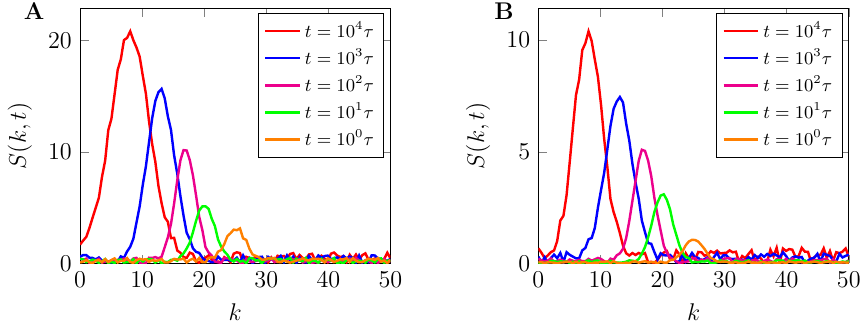
Figure 7. Spherically averaged structure functions. ( A ) Structure function corresponding to Fig- ures 5A and ( B ) structure function corresponding to Figure 6A at different times plotted against k the wavenumber k = . As can be observed, both structure functions reveal several controllable | | characteristic length scales that emerge from the fast and slow coarsening of phase-separated patterns. In both ( A , B ), during the early stage of phase separation, the structure function grows exponentially, signifying an almost constant domain size due to the suppressed interconversion of phase separating proteins by macromolecular crowders. The inclusion of chemical reactions reduces the peaks of the structure functions which eventually leads to the arrested coarsening and formation of labyrinthine morphologies, as observed in late stages of Figures 6B,C.